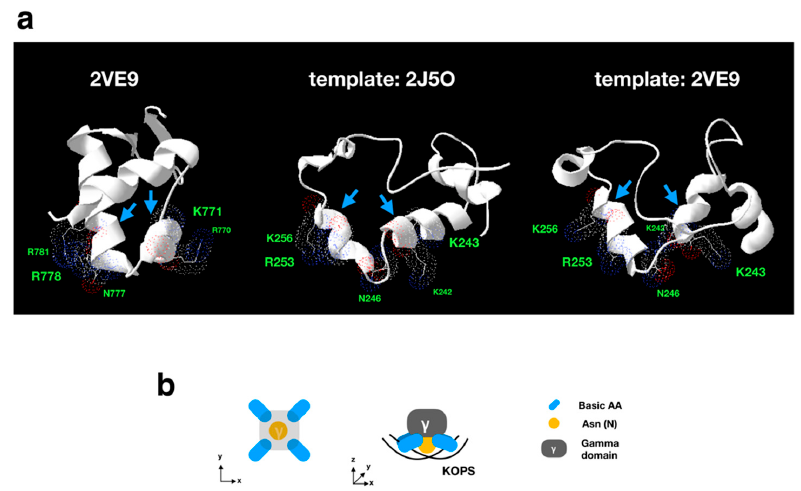
Figure 8. Homology modeling analysis of APMV-FtsK gamma domain. ( a ) Estimated structures of FtsK gamma domain using two different templates of P. aeruginosa -FtsK (PDBID; middle: 2J5O; right: 2VE9). The left model is the gamma domain of P. aeruginosa -FtsK (PDBID: 2VE9). Side chains on the left model are directly bound to FtsK orienting polar sequences (KOPS), while the other two models are estimated amino acids, which are functionally homologous to 2VE9. Blue arrows indicate two helix motifs harboring KOPS binding residues. ( b ) Model of the gamma domain of APMV-FtsK against KOPS. Four basic amino acids and Asn (N) correspond to the side chain in every model on panel (a).